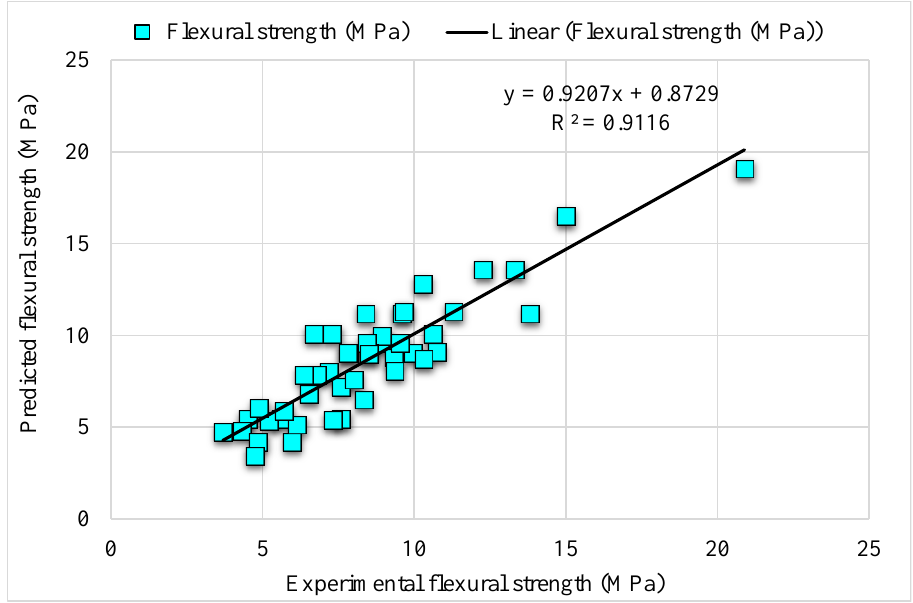
Figure 6. Experimental and bagging predicted results.